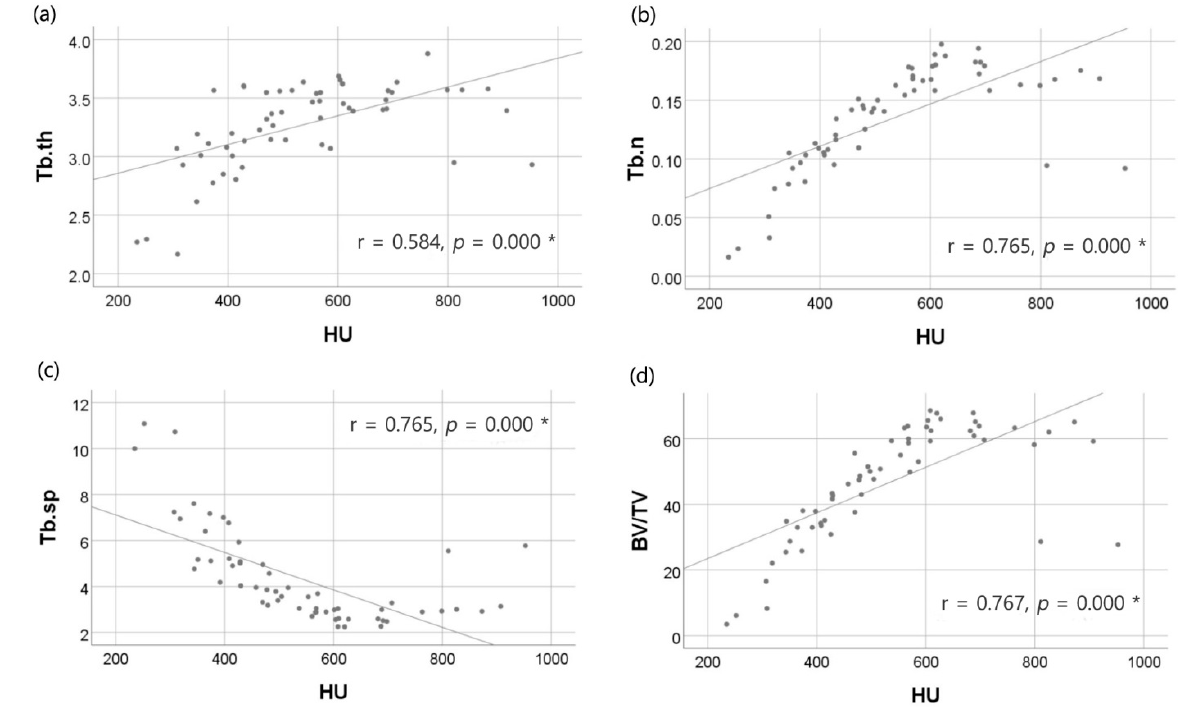
Figure 3. Correlations between the Hounsfield unit measurement and trabecular microstructure parameters: ( a ) Positive correlation between Hounsfield unit (HU) and trabecular thickness (Tb.th); ( b ) positive correlation between HU and trabecular number (Tb.n); ( c ) negative correlation between HU and trabecular seperation (Tb.sp); ( d ) positive correlation between HU and bone volume fraction (BV/TV). * p < 0.001